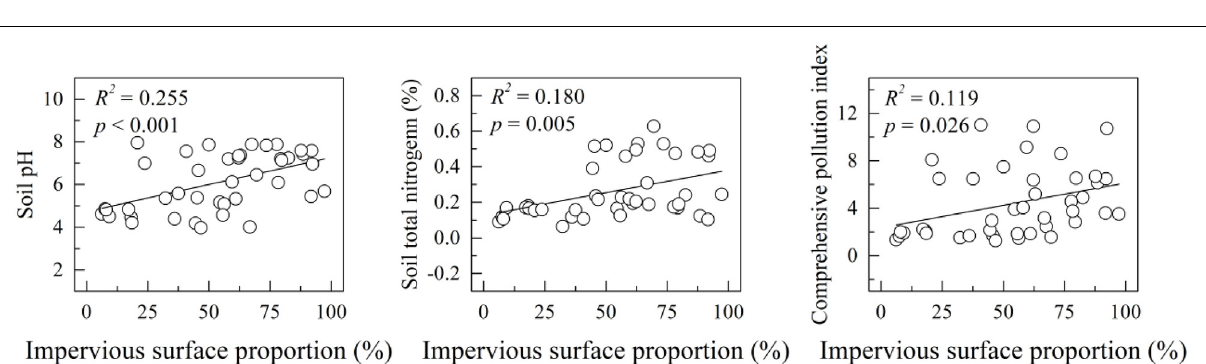
FIGURE 3 | Variations of soil property with impervious surface ratio. R 2 and p were the fitness and significance of the linear regression